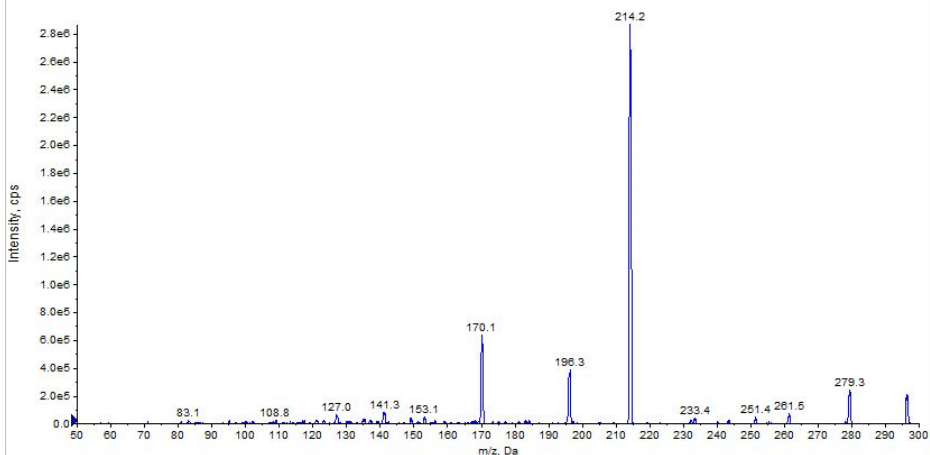
Figure 12 . Product ion scan of URB602 compound obtained by QqQ. Exponential scale to base 10.